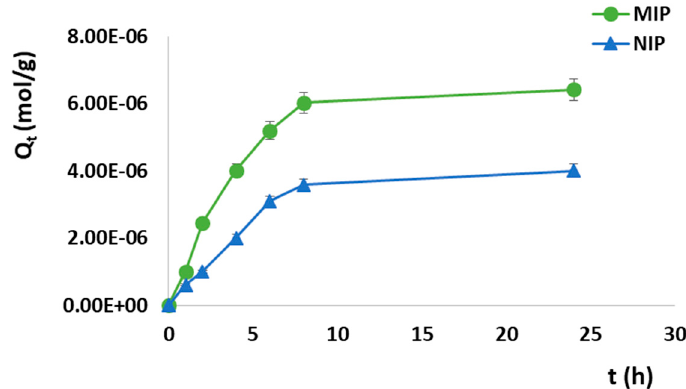
Figure 6. SUT adsorption kinetic curves for MIP and Non-Imprinted Polymer (NIP).